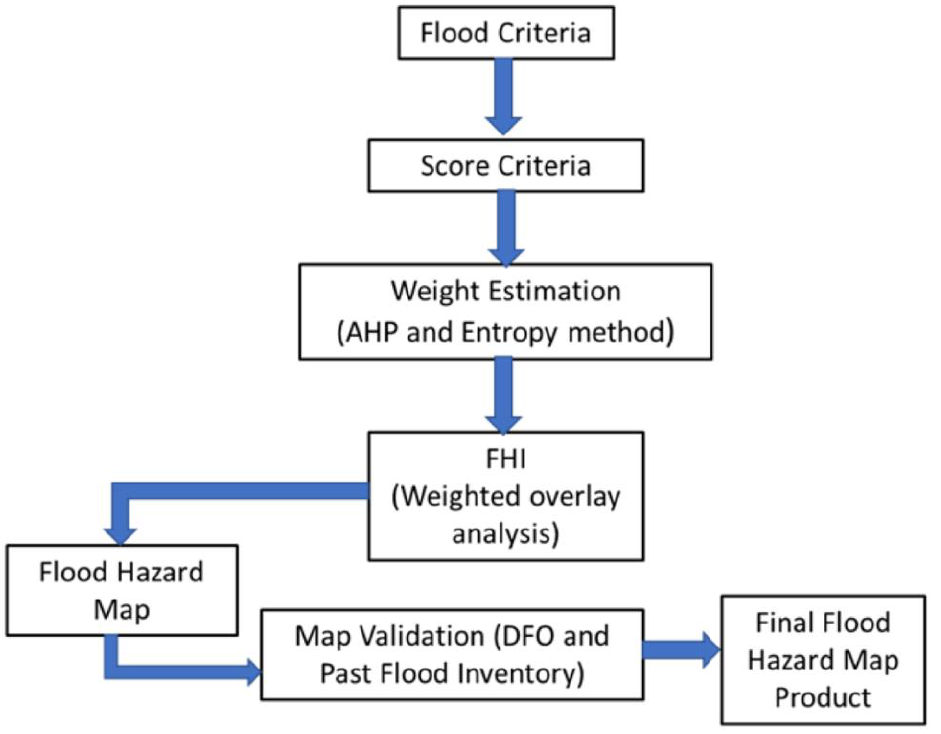
Figure 3. Flood hazard mapping workflow.